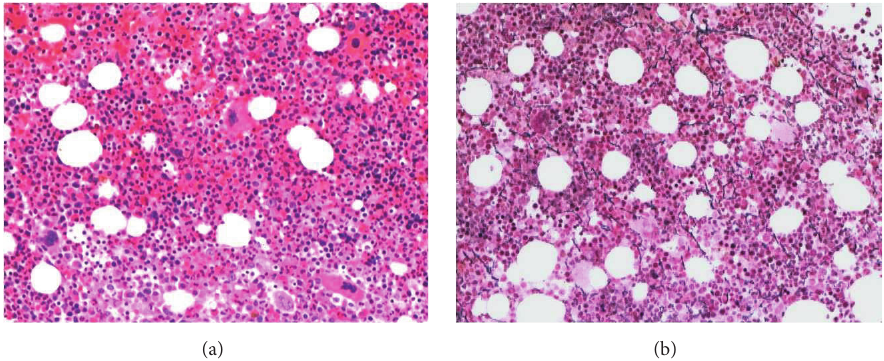
Figure 3: (a) Postconsolidation bone marrow biopsy showing 80% cellular marrow and mild megakaryocytic hyperplasia. The scattered megakaryocytes are morphologically unremarkable. (b) Reticulin stain of the postconsolidation bone marrow showing complete resolution of marrow